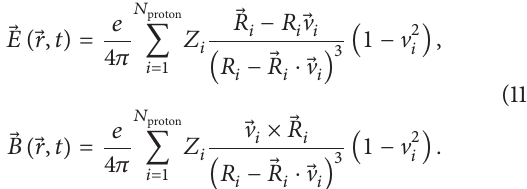
Figure 12: Distribution of strings created between the partons of two colliding Pb nuclei as a function of space-time rapidity ( 𝜂 𝑠 ) at √𝑠 2.76 TeV for 0-1% (a) and 40–50% (b) collision centrality. The figure is taken from